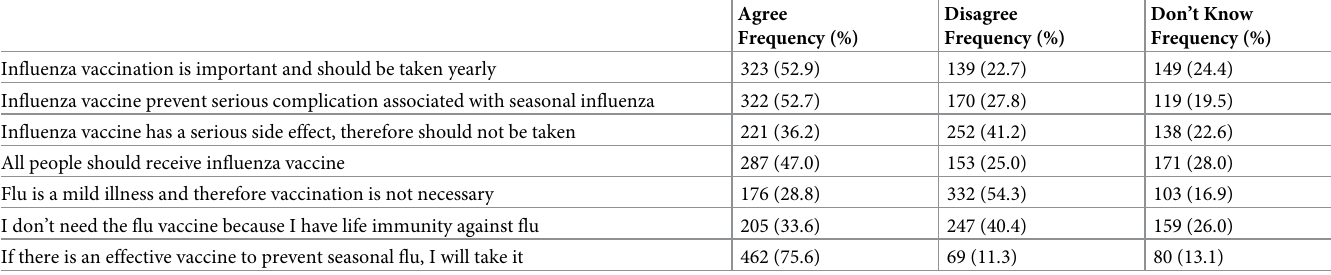
Table 5. Participants’ attitudes regarding influenza vaccination (N =